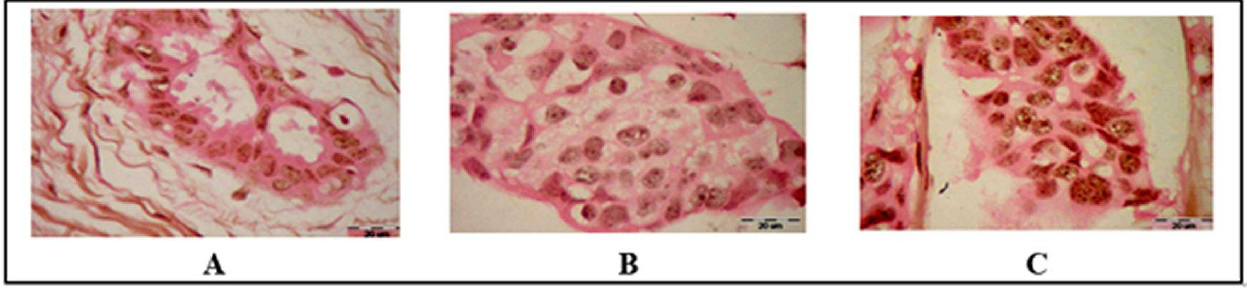
Figure 1: Histochemical Results of tested samples (Silver stain Bar=20 µm). A: Benign Fibroadenoma case show cluster black dotes of Ag NORs in few epithelial breast cells B: Malignant invasive ductal carcinoma (IDC) grade II case, note clusters of black dotes in nucleoli and increase the number of satellite Ag NORs dotes in nuclei matrix. C: Malignant IDC grade III case showing increased number of cluster black dotes of AgNORs in most of the invasive malignant cells.